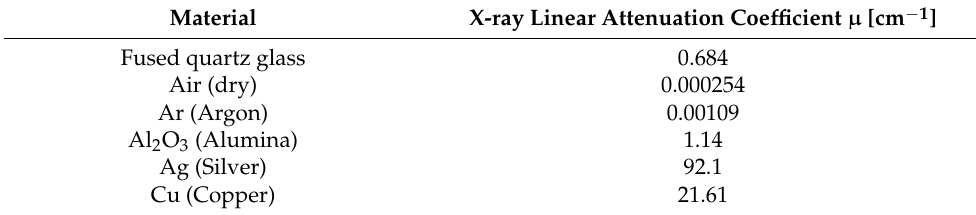
Table 1. Some X-ray linear attenuation coefficients at 50 keV energy, from [25].